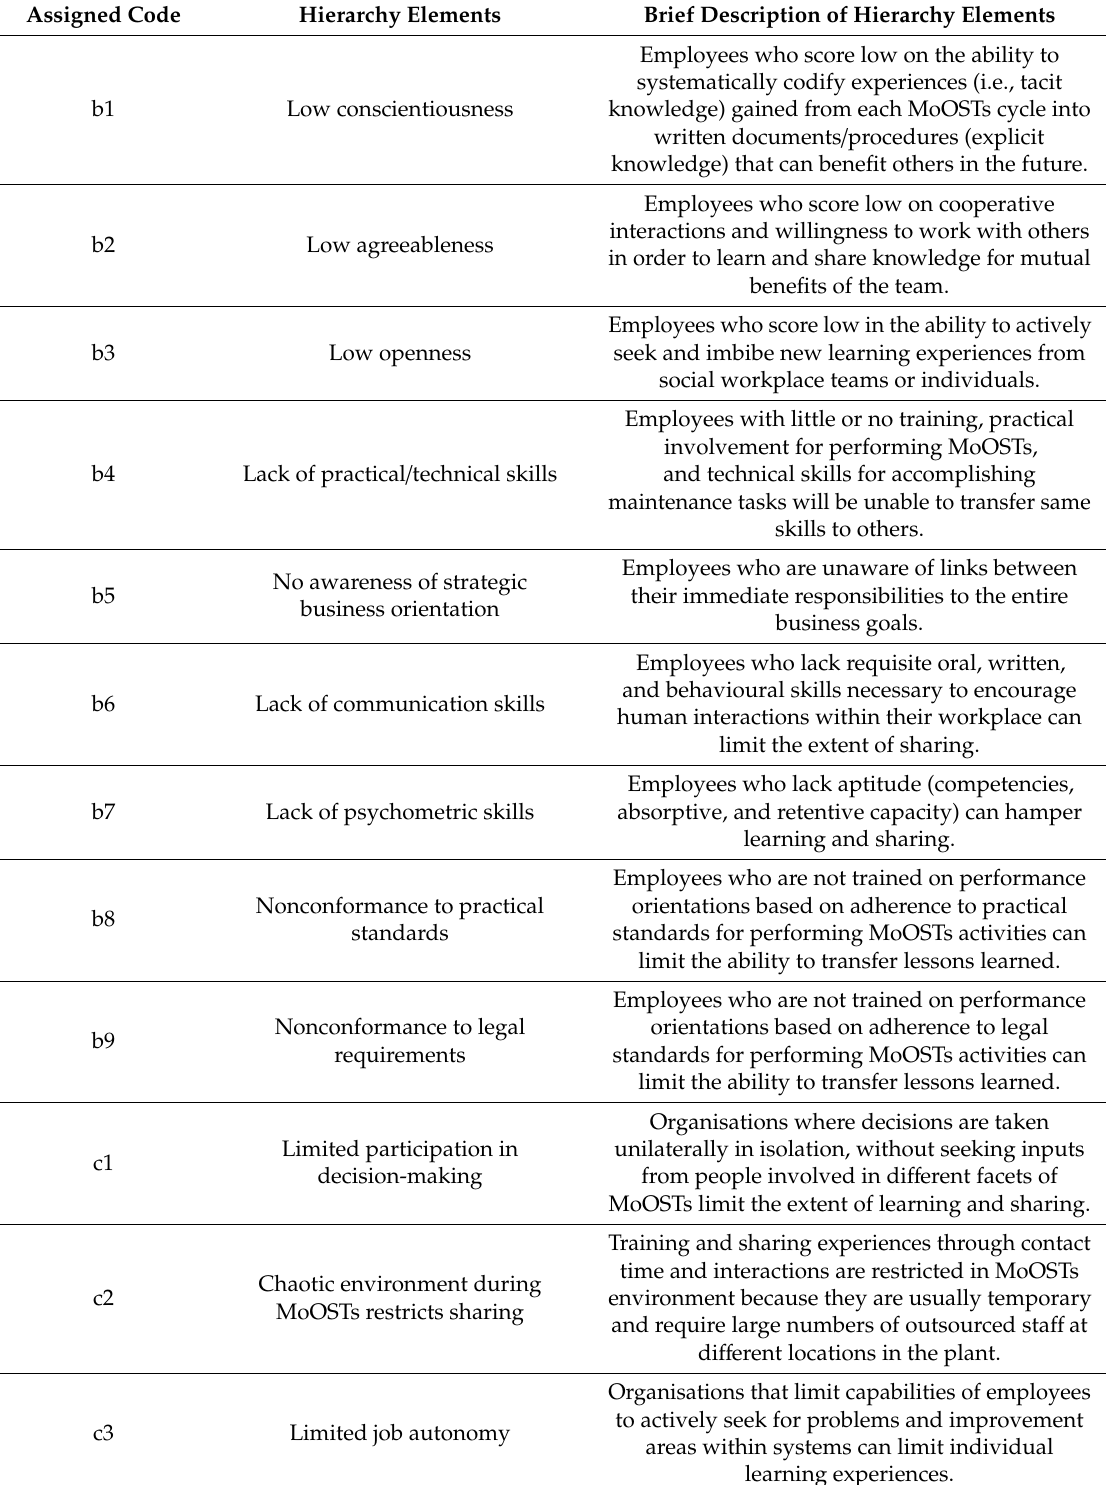
Table A9. Hierarchy elements and their brief